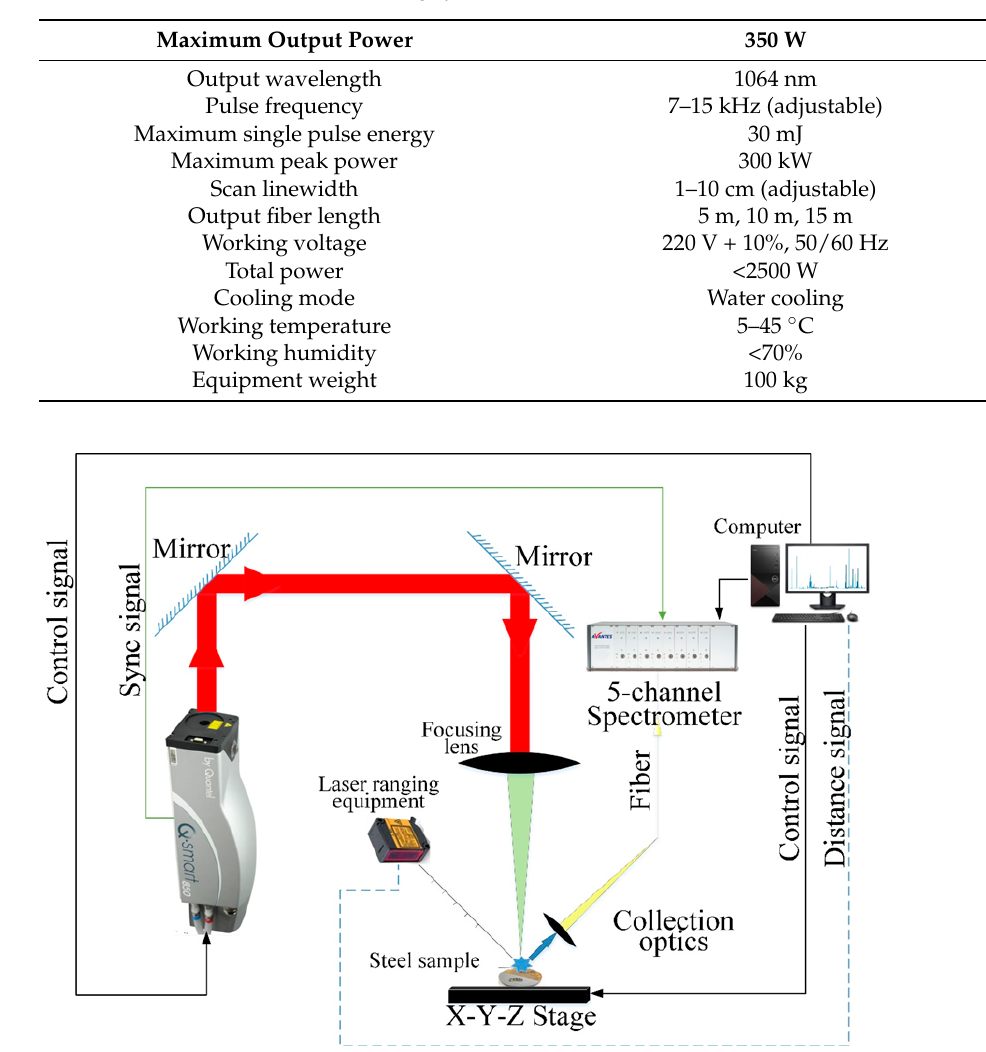
Table 1. Parameter of the laser cleaning system.